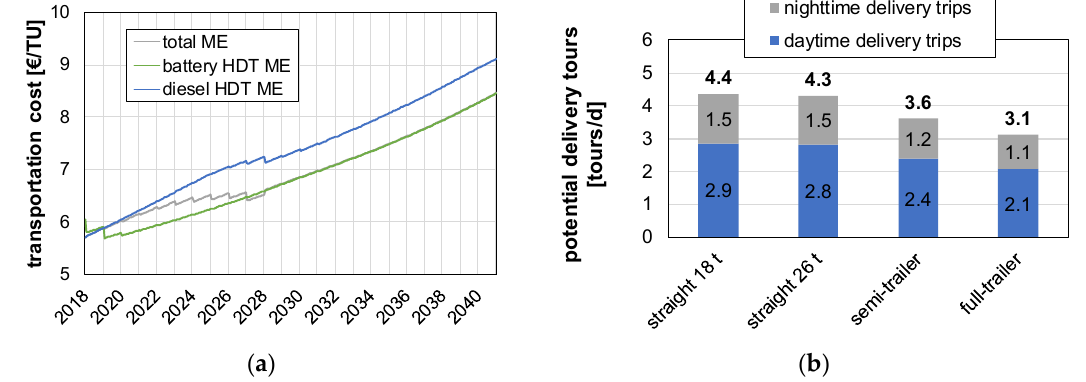
Figure 7. Development of transportation costs of pure battery and diesel HDTs fleets in comparison to calculated fleet mix (total) over time ( a ) and potential of daily delivery trips for different truck types during daytime and nighttime. Scenario ME ( b ).